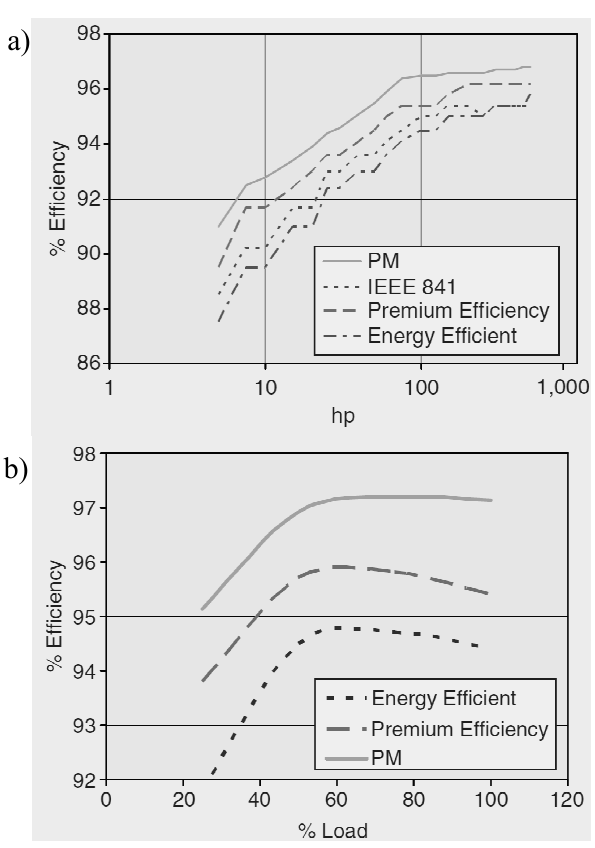
Figure 4. The improved e ffi ciency at rated load (a) and typical par- tial load e ffi ciencies (b) for PM motors and energy e ffi cient IMs (Melfi et al.,